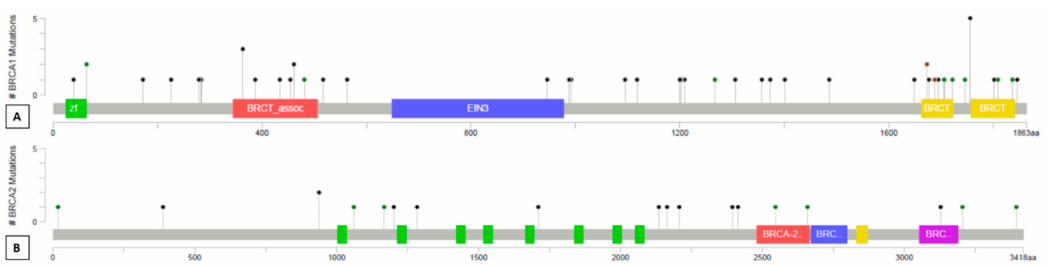
Figure 2. Lollipop plots of mutation distribution on BRCA1 ( A ) and BRCA2 ( B ) protein and domains. The diagrams linearly represent BRCA1 / 2 protein domains ( x -axis). BRCA1 domains: green, C3HC4-type RING finger; red, serine-rich domain associated with BRCT; blue, ethylene insensitive 3; yellow, BRCA1 C terminus domain. BRCA2 domains: green, BRCA2 repeats; red, BRCA2 helical; blue, BRCA2 oligonucleotide / oligosaccharide-binding domain 1; yellow, tower; purple, BRCA2 oligonucleotide / oligosaccharide-binding domain 3. Each mutation is represented by single lollipop; the stick lengths indicate mutation frequency ( y -axis), and dots are color-coded according to alteration type: green, missense mutations; black, truncating mutations (frameshift or nonsense mutations); brown dots, in-frame mutations. Intronic variants are not reported. Graphs created using Mutation Mapper tool, cBioportal (http: // www.cbioportal.org / mutation_mapper) and manually curated. BRCA1: RefSeq: NM_007294, Ensembl: ENST00000357654, CCDS: CCDS11453, UniProt: BRCA1_HUMAN. BRCA2: RefSeq: NM_000059, Ensembl: ENST00000380152, CCDS: CCDS9344, UniProt: